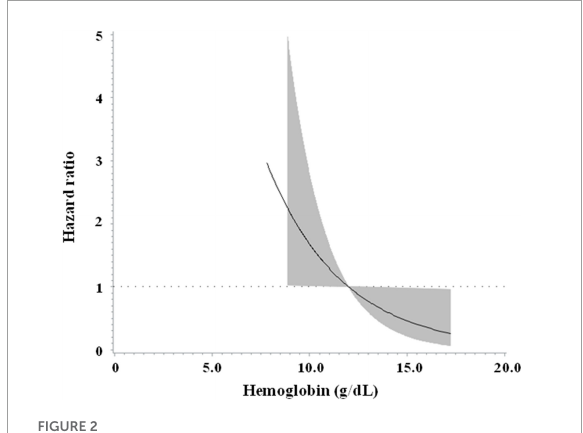
FIGURE2 Cubic spline of pre-operative hemoglobin levels vs. risk of all-cause mortality in the overall